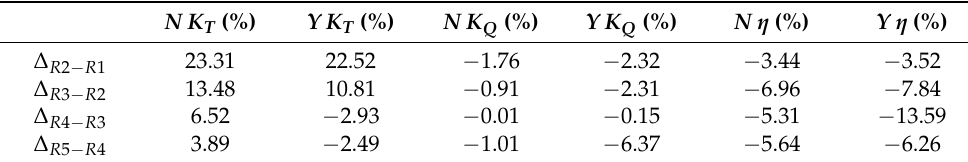
Figure 10. Hydrodynamic performance at different rotating speeds. ( a ) Hydrodynamic parameters at different rotating speeds. ( b ) Difference among the hydrodynamic parameters. Table 8. Difference between different rotating speeds.